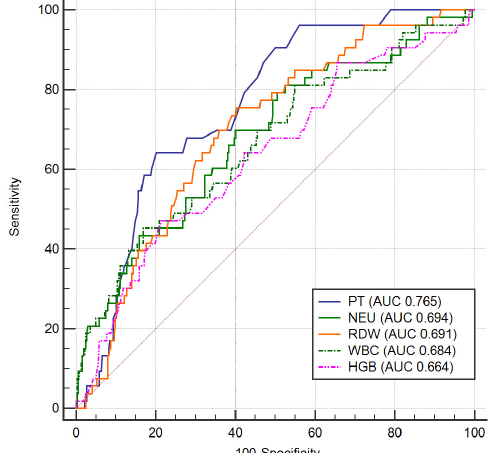
Figure 2. ROC curves for mortality prediction in ACS. Legend: PT—prothrombin time; NEU—neutrophils; RDW—red cell distribution width; WBC—white blood cells; HGB—hemoglobin; ACS —acute coronary syndrome.